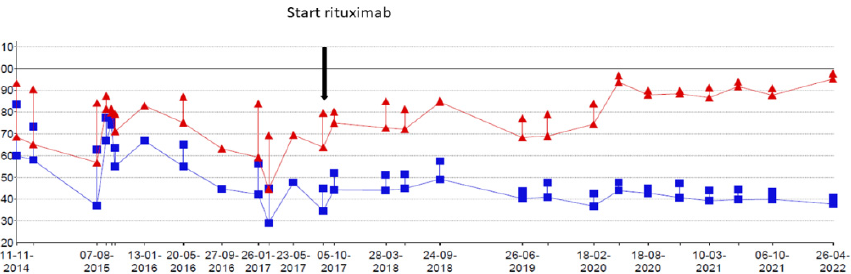
Figure 2. Lung function over time (forced expiratory volume in 1 s (FEV1) in blue and forced vital capacity (FVC) in red expressed as percent predicted of normal. FVC shows a gradual increase while FEV1 remains stable.